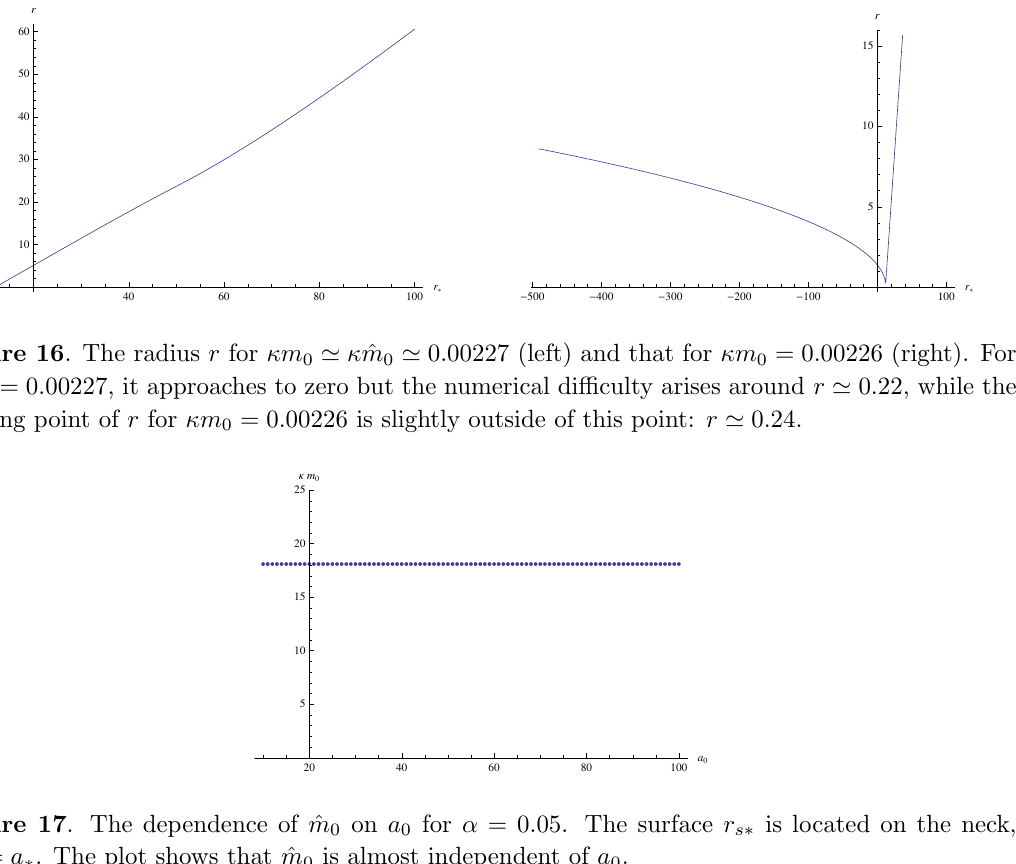
M = 4 (cid:25) m r 3 to r = a were approximately correct, the density would be related to a s 0 s 3 m (cid:24) Mr (cid:0) 3 0